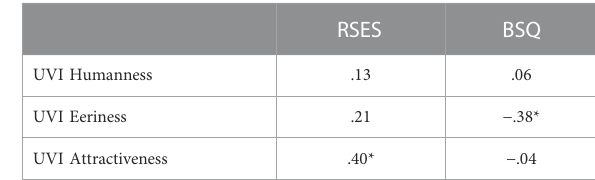
TABLE 4 Correlations between RSES and BSQ and the different affective appraisal scores. Single-asterisks indicate signi fi cant p -values.